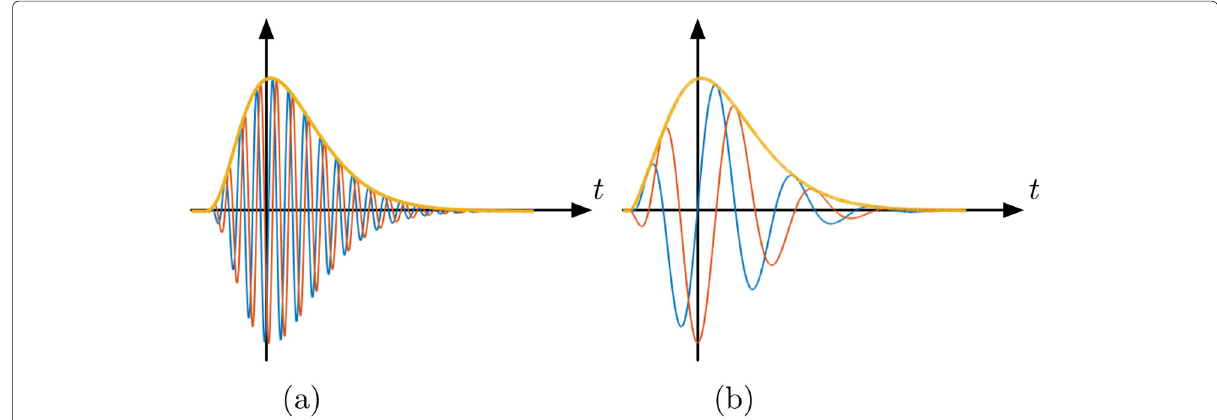
Fig. 1 Gammatone wavelets ψ ( t ) in the time domain with quality factors a Q = 4 and b Q = 1. Oscillations (red, blue) are the real and imaginary parts. The envelope (yellow) is the complex